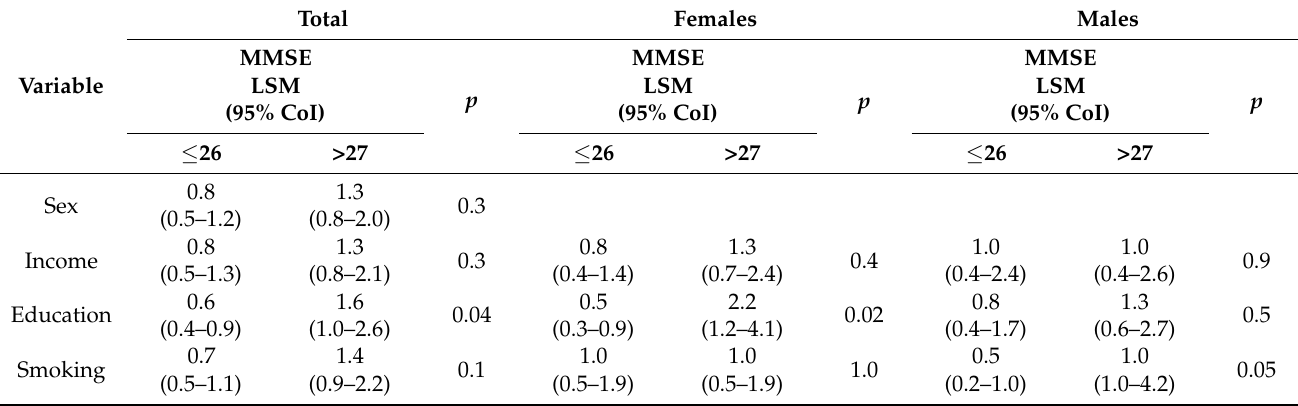
Table 7. Demographic characteristics by MMSE scores indicative of MCI in the total cohort and by sex (categorical variables).